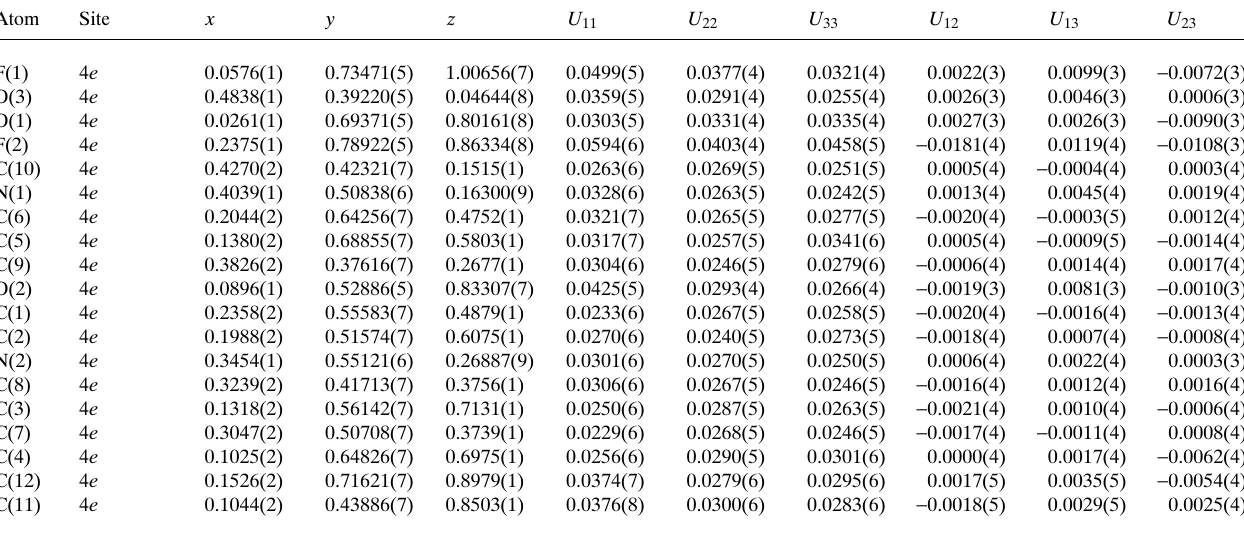
Table 3. Atomic coordinates and displacement parameters (in Å 2 )